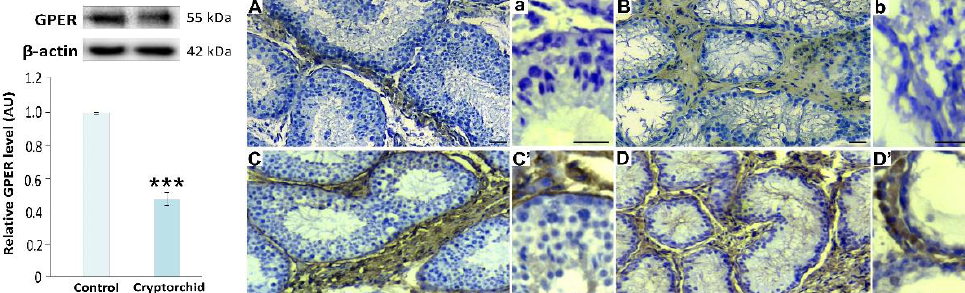
Figure 2. Left panel. Qualitative expression and relative expression (arbitrary units) of GPER in healthy (control) and cryptorchid horse testes. The relative amount of GPER normalized to β-actin. The relative intensity of bands from three separate analyses is expressed as means ± SD. Asterisks show significant differences between healthy and cryptorchid testes. Significant difference is denoted *** p < 0.001. Right panel. Representative microphotographs of immunohistochemical localization of GPER ( A , B ) and INSL3 ( C , D and higher magnification C’ , D’ with positively immunostained individual Leydig cells) in healthy ( A , C , C’ ) and cryptorchid ( B , D , D’ ) horse testes. a , b —negative controls representative for GPER or INSL3 staining. Staining with DAB and counterstaining with hematoxylin. Bar 45 µm. Staining was performed at three serial sections from each animal.